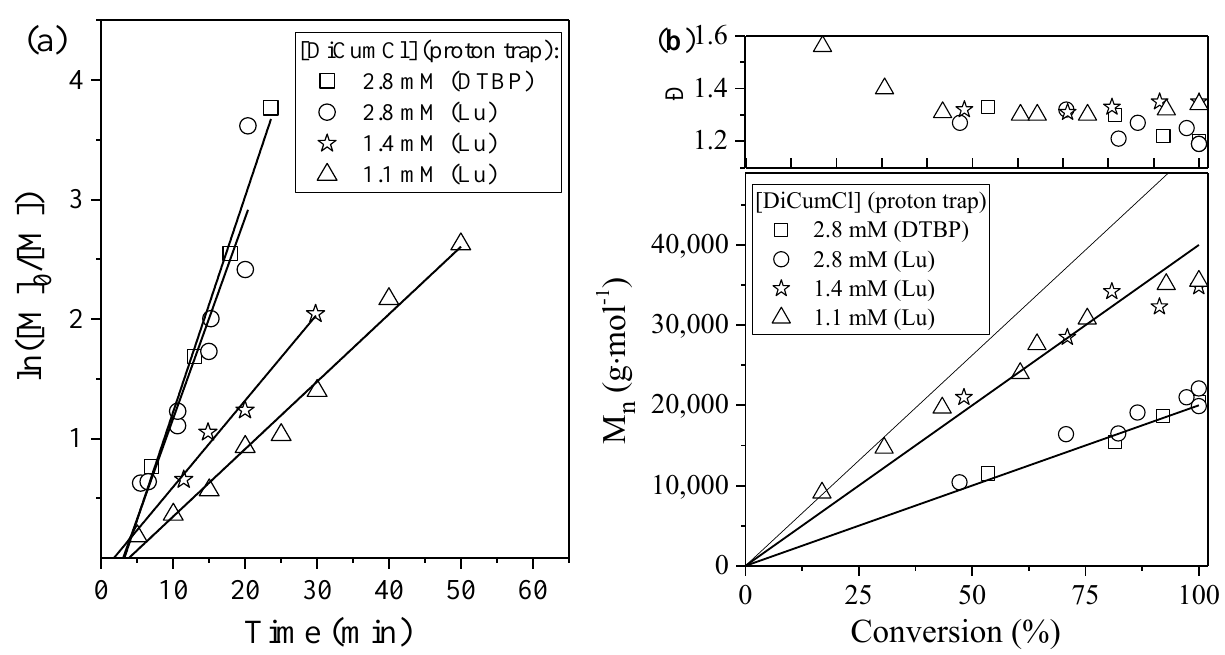
Figure 1. ( а ) First-order plots and ( b ) M n , Đ vs. conversion dependences for cationic polymerization of isobutylene at with DiCumCl/TiCl 4 /proton trap initiating system in CH 2 Cl 2 /MCH 40:60 v / v at different initiator concentrations at −8 0 °C: [IB] = 1.0 M; [TiCl 4 ] = 59 mM; [DTBP] = [Lu] = 5.8 mM.